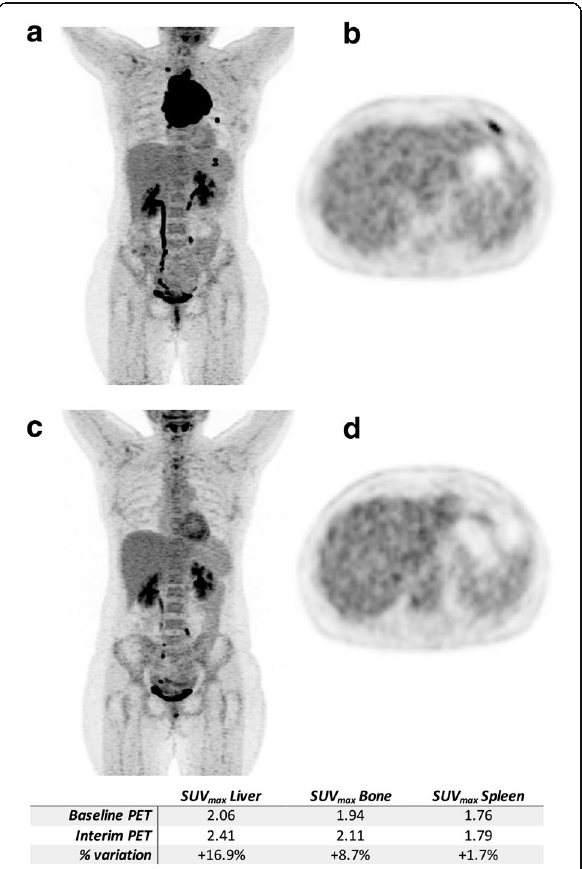
Fig. 3 A 47-year-old female patient imaged at baseline ( a , b ) and after 4 cycles of R-ACVP ( c , d ). Interim PET/CT was performed 17 days and 12 days following the last injection of chemotherapy and G-CSF, respectively. The injected G-CSF was lenogastrim, at a dosage of 34MUI daily for a 5-day period. Thanks to a time-lapse between the last chemotherapy injection and interim PET/CT, no significant increased bone marrow or splenic uptake are